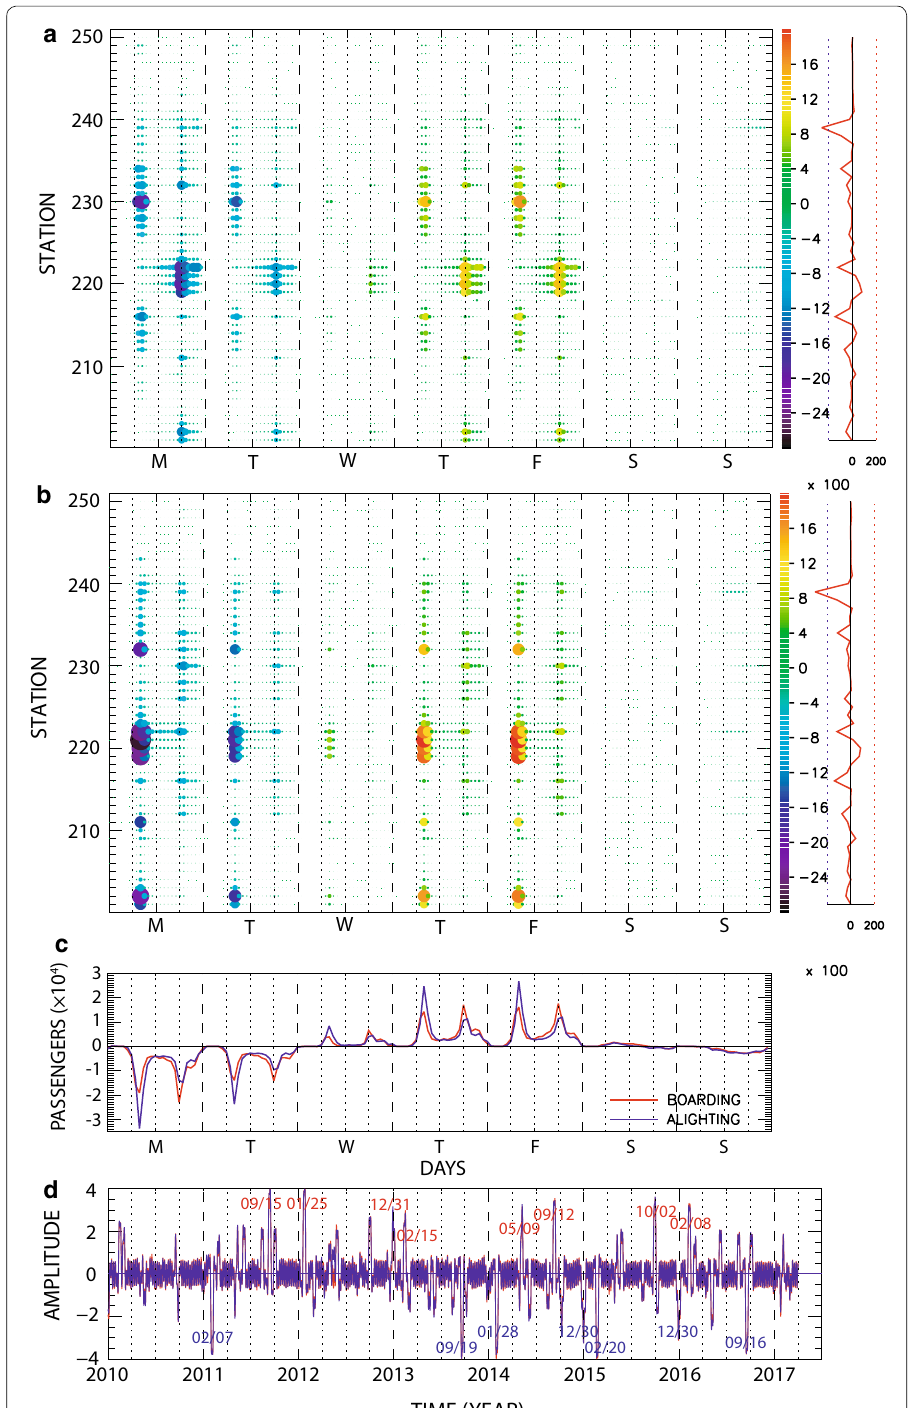
Fig. 7 The second mode of CSEOF representing the weekly patterns of passengers for Subway Line #2. a hourly and total number of boarding passengers at each of the 50 subway stations numbered from 201 to 250; b hourly and total number of alighting passengers; c number of boarding (red) and alighting passengers in all stations; and d corresponding amplitude time series. Four sets of stations show regular patterns